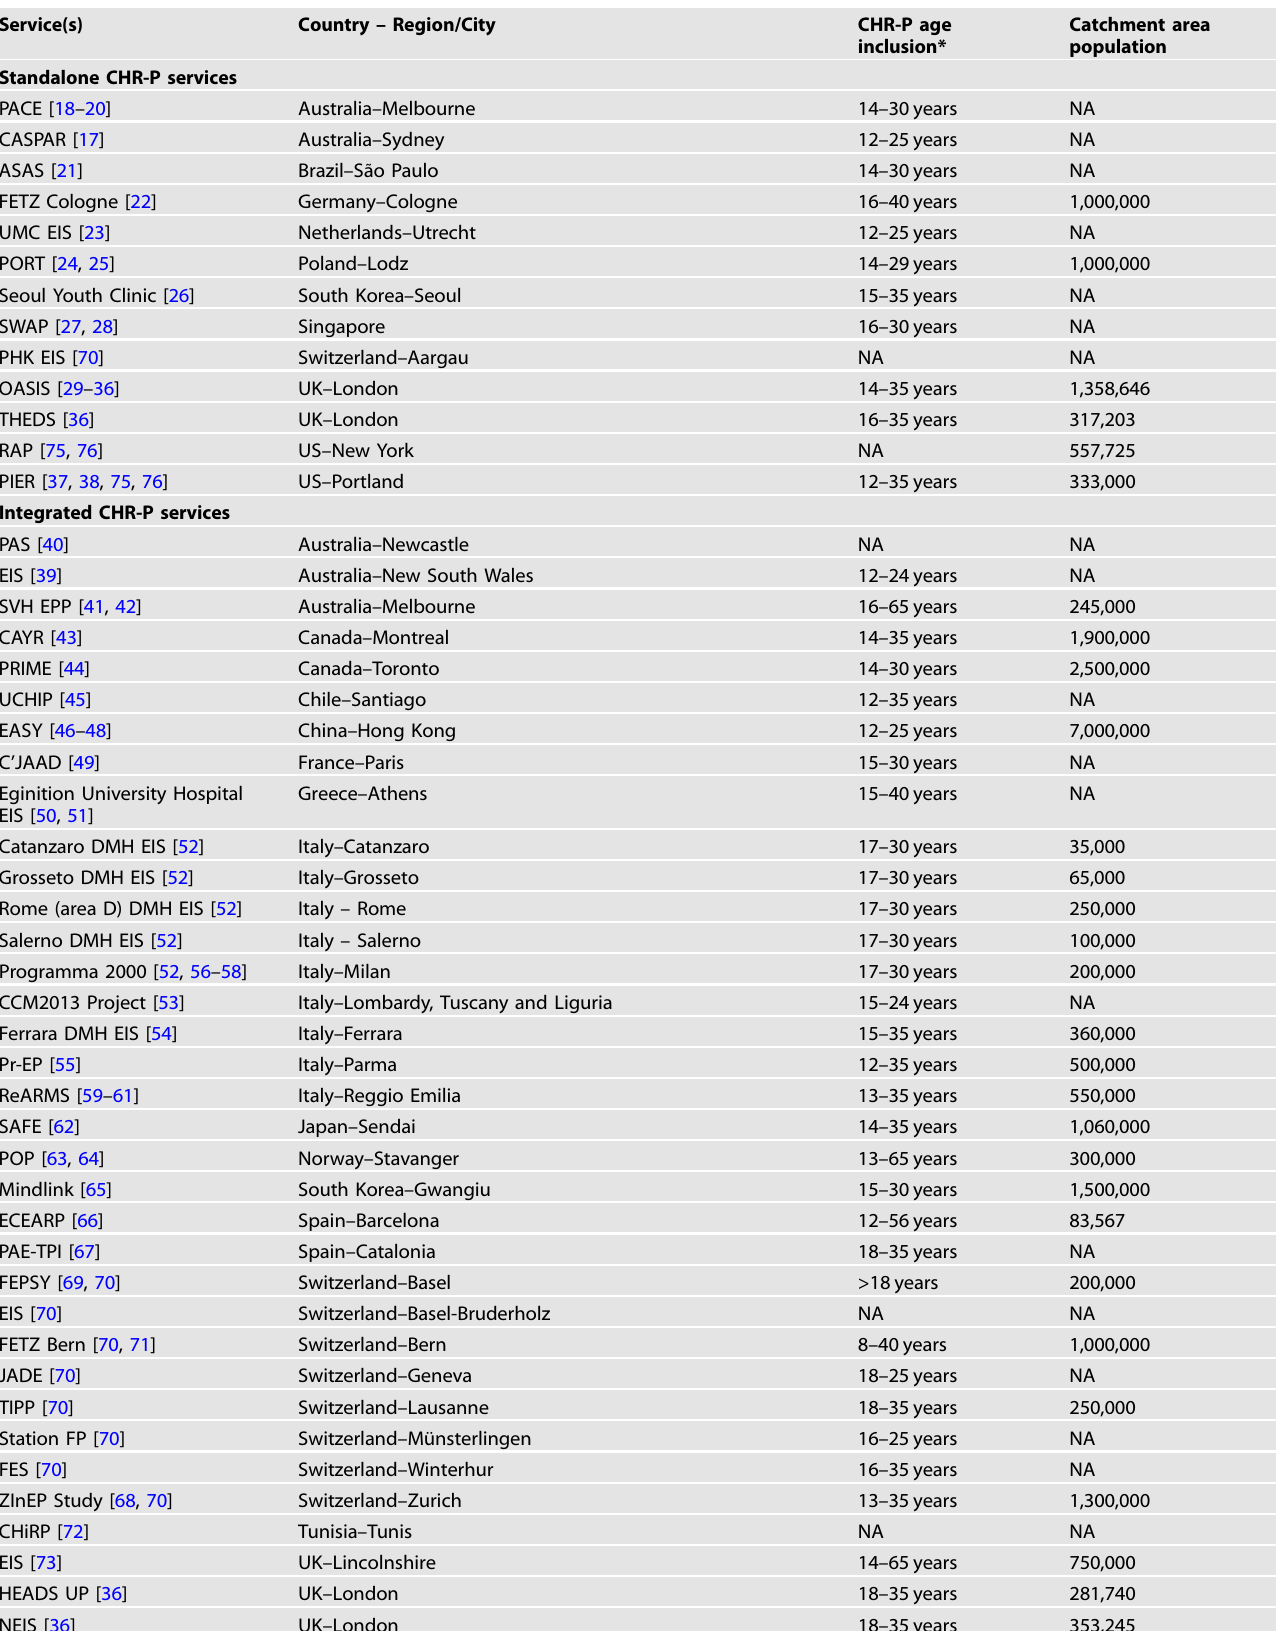
Table 2. Description of CHR-P services included in the